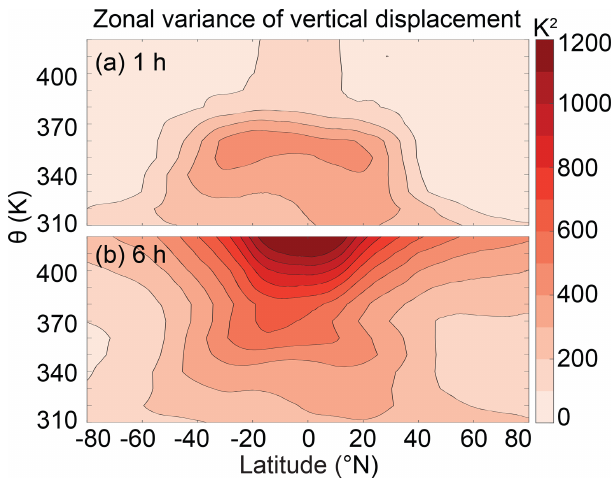
Figure 5. The distribution of trajectories’ potential temperature for 1 (black) and 6h (red) runs initialized on the interpolated 340K and 400K isentropes after 1, 40, and 80d. Different y axes are used to highlight the relevant ranges of potential